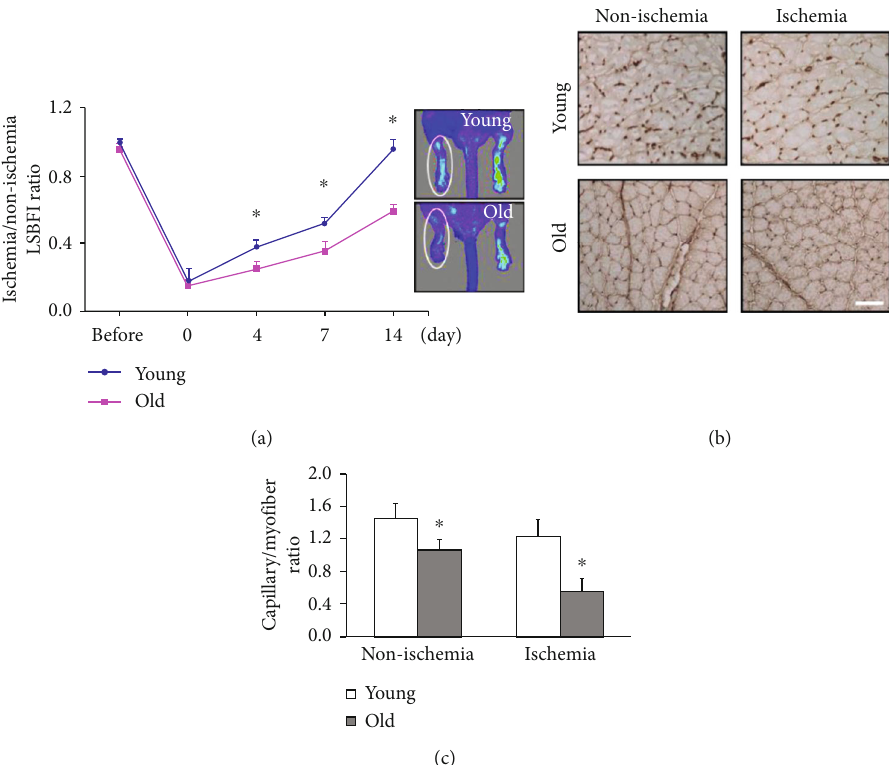
Figure 1: Aging resulted in impaired capillary formation and blood fl ow recovery in response to ischemia in the muscles of C57BL/6J mice. (a) Representative LSBFI result and quantitative data show the ratio of ischemia to nonischemia blood fl ow in young (8-week-old) and aged (96-week-old) CatK +/+ mice. (b) Representative images show the capillary density in nonischemic and ischemic thigh adductor muscles. (c) Quantitative analyses revealed that CatK − / − impaired the capillary density in the ischemic muscle. Data are mean ± SEM ( n = 6 – 8 ). ∗ p < 0 : 05 vs. corresponding controls (days 4, 7, and 14) by two-way repeated-measures ANOVA and Bonferroni post hoc tests (i) or one-way ANOVA and Tukey ’ s post hoc tests